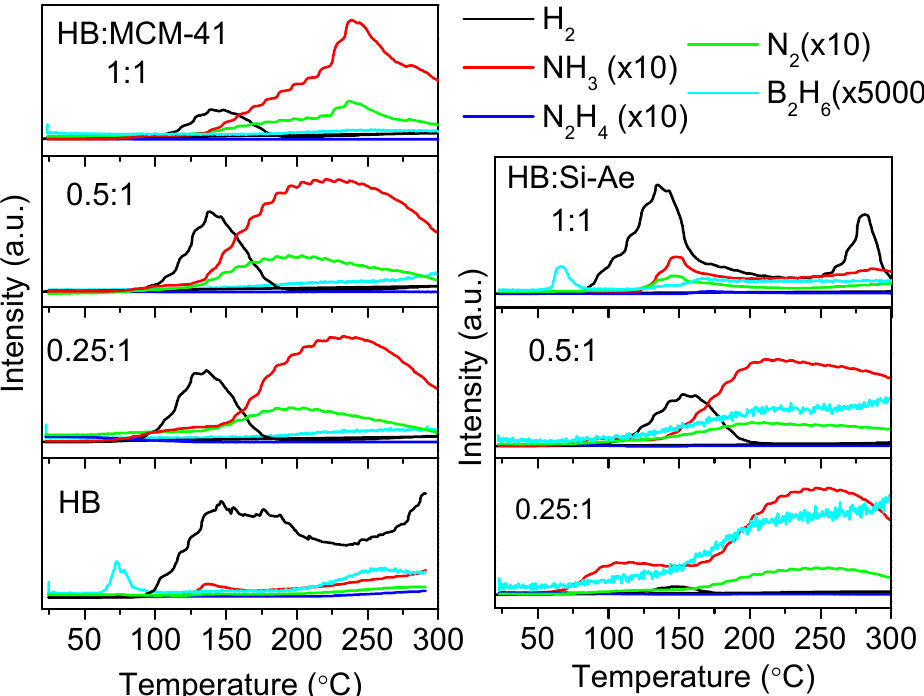
Figure 4. TPD-MS of HB, HB:MCM-41 and HB:Si-Ae at various loading at heating rate of 5 °C min − 1 . For the ease of illustration, the intensity of NH 3 , N 2 H 4 , N 2 signals in TPD-MS analyses were intensi- fied by a factor of 10, respectively, while B 2 H 6 signal was intensified by